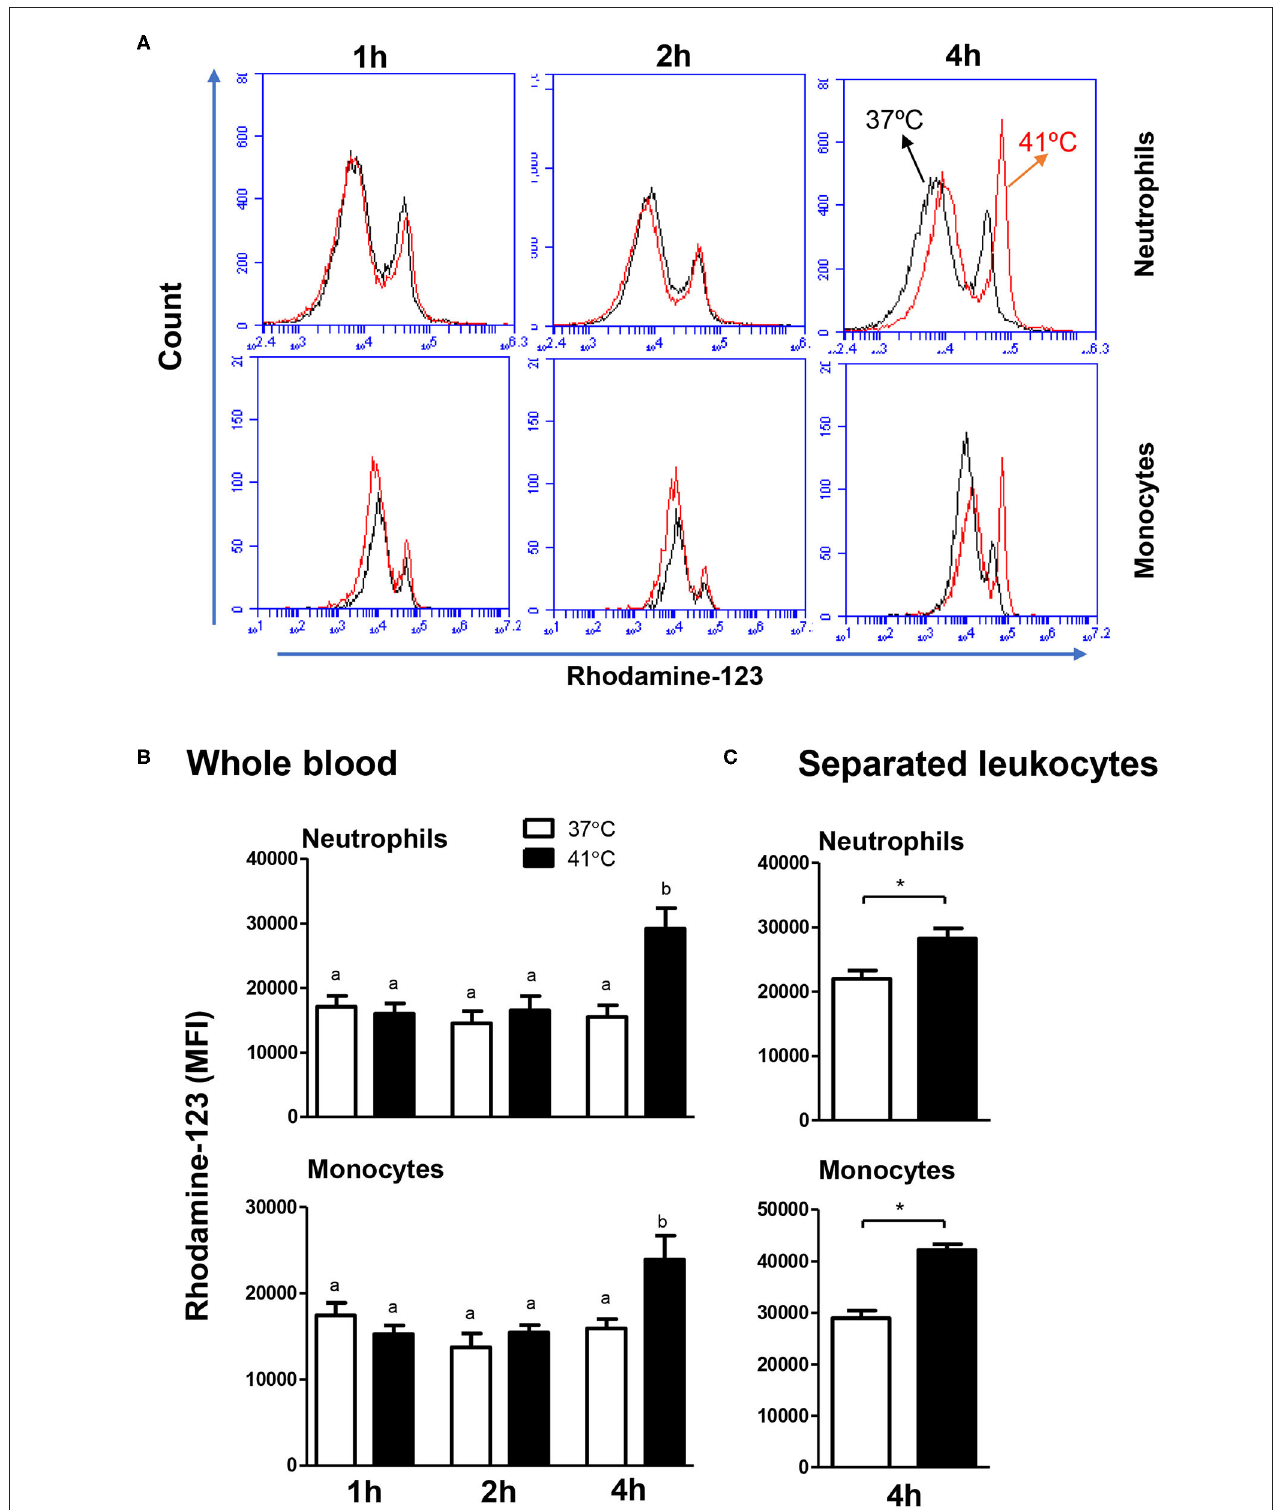
FIGURE 5 | The impact of heat stress on S. aureus -induced ROS-response of camel neutrophils and monocytes. (A) Flow cytometric analysis of ROS production by camel neutrophils and monocytes. Separated camel leukocytes were stimulated with heat-killed S. aureus bacteria in the presence of the ROS-sensitive dye dihydrorohdamin-123 (DHR-123) and the reactive oxygen-dependent generation of rhodamine-123 was analyzed by flow cytometry. After gating on neutrophils and